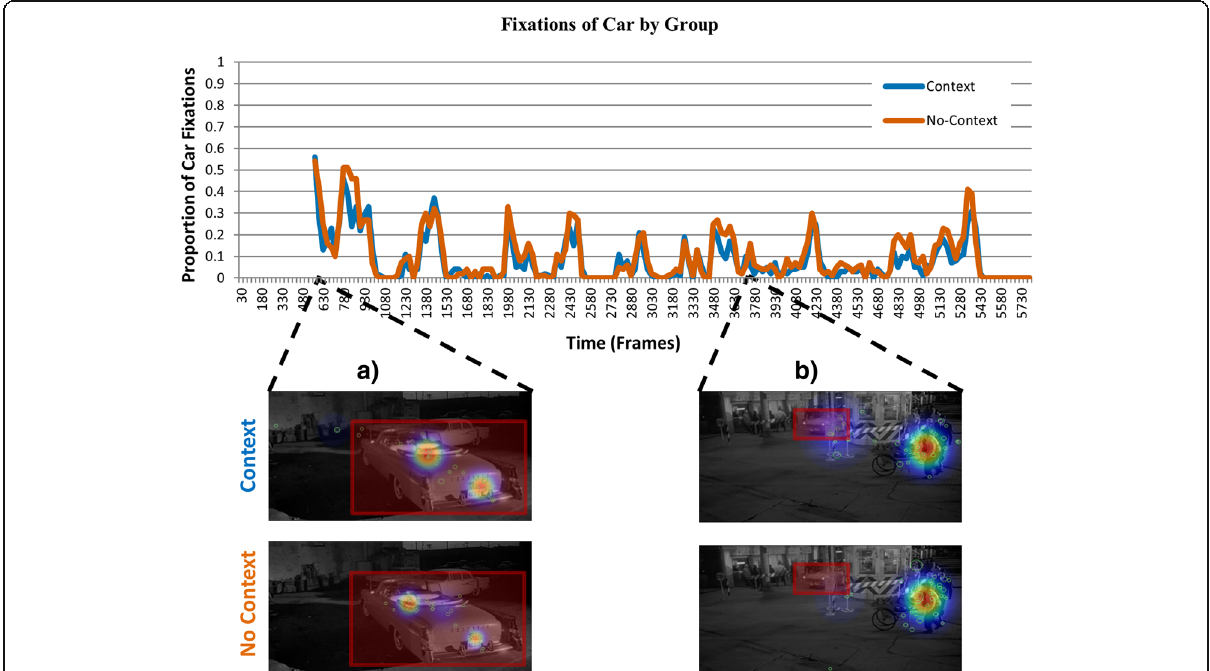
Fig. 3 Top : Proportion of participants fixating the car by context condition throughout the film clip (shown here in 3-s bins due to resolution limitations of the figure). The higher the value, the more participants were looking at the car. Bottom : Film stills show the region of interest for the frame, with fixation and heat maps superimposed. Still set a shows a time point when the car was fixated by most participants, and set b shows when the car was minimally fixated. Note that frame a shows the single highest proportion of viewers fixating the car region of interest, which was at the start of the common viewing period across both context